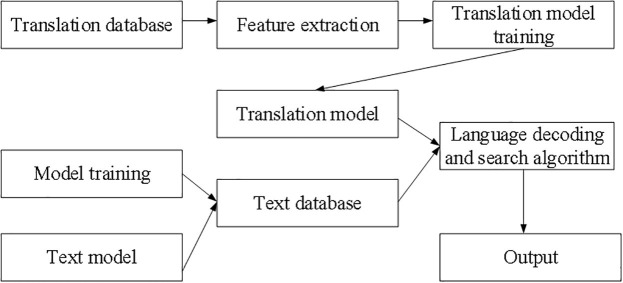
Functions of a translation model.